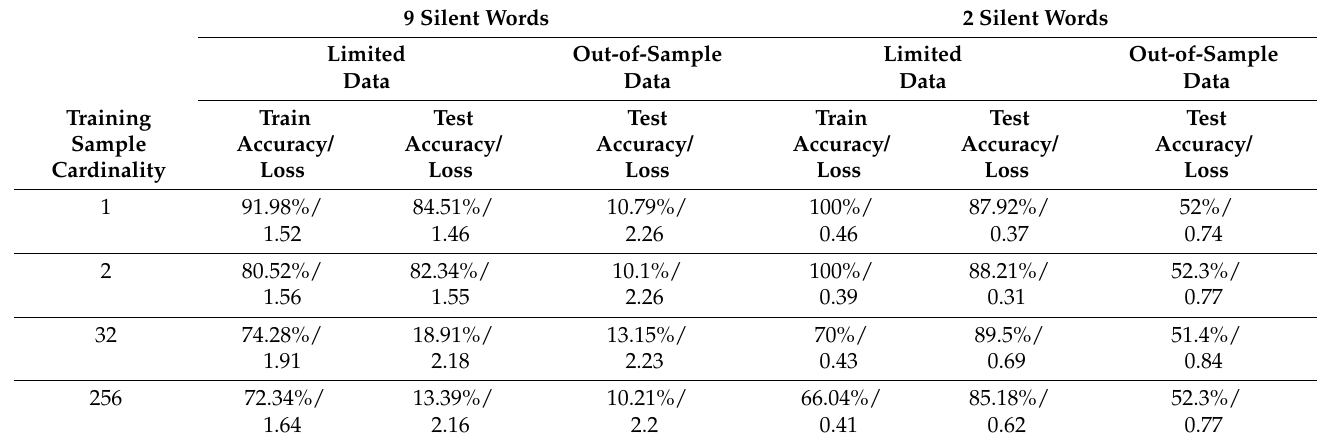
Table 4. Results of “ResNet18 +